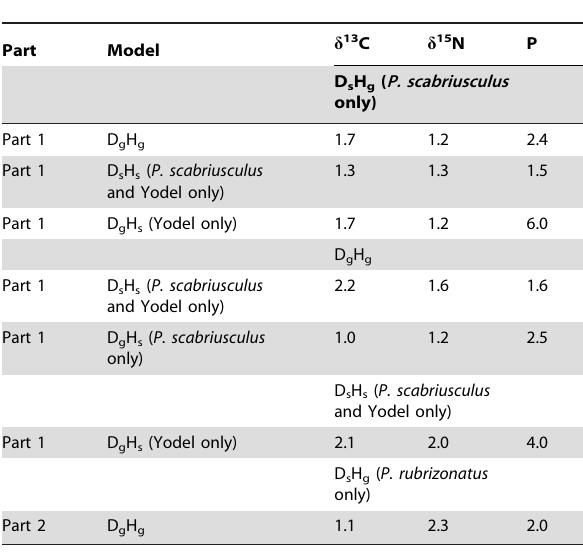
Table 8. Comparison of variances in d -space (for both d 13 C and d 15 N) with p-space (Shannon-Wiener information measure) for models using the common prey species (Part 1) and models using the common prey species and incorporated distance between sites (Part